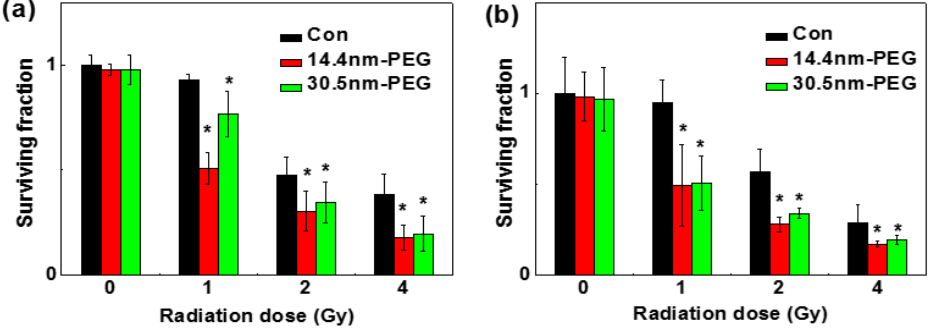
Figure 8. Cloning formations in H22 ( a ) and HepG2 cells ( b ) after treated with 0.05 mM 14.4 or 30.5 nm PEG-coated GNPs.